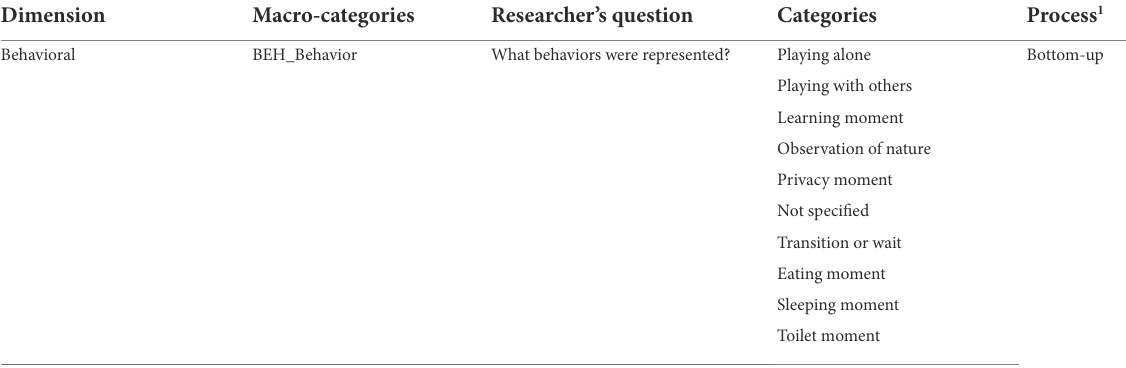
TABLE 2 Behavioral dimension: macro-categories and categories included in the DRAW.IN.G. grid.